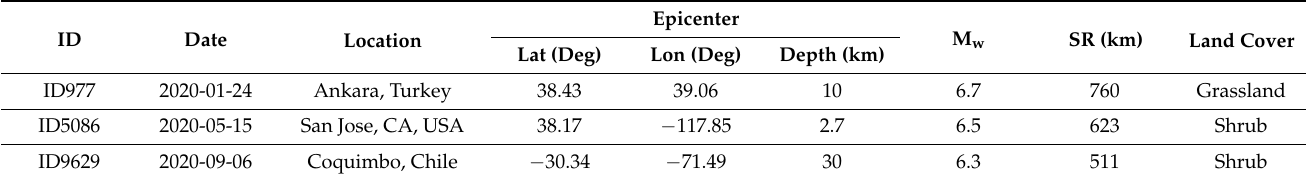
Table 3. Details of earthquakes M w > 6 in 2020 [33] that are presented in Figure 4. (From a total of 1350 earthquakes